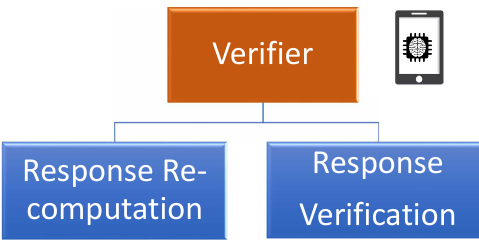
Figure 10. Key elements of the verifier role.